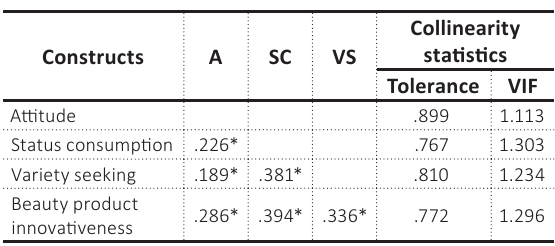
Table 4. Correlation coefficients and collinearity